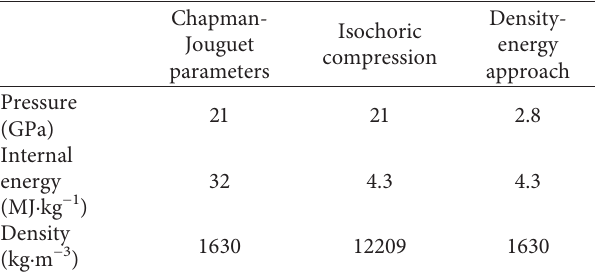
Table 1: Compressed balloon possible sets of